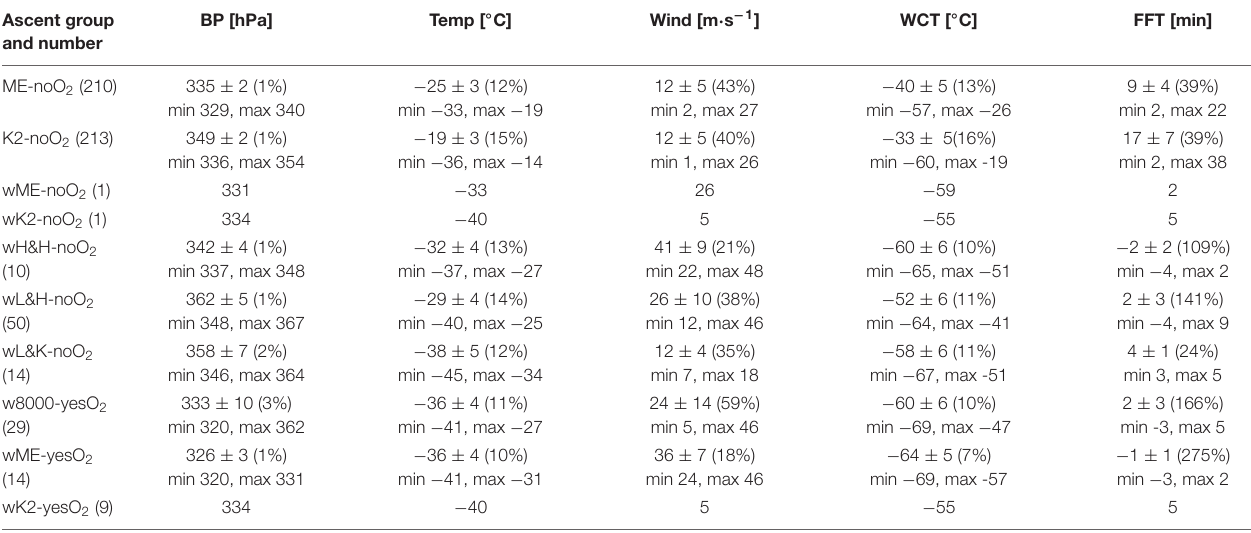
TABLE 3 | Barometric pressure, ambient temperature, wind speed and thermal stress indices: WCT and FFT for the 499 ascents without oxygen support and 29 oxygen-supported ascents of 8K peaks we analyzed: number of ascents, means ± standard deviation (SD), coefficient of variation (CV%), minimum and maximum